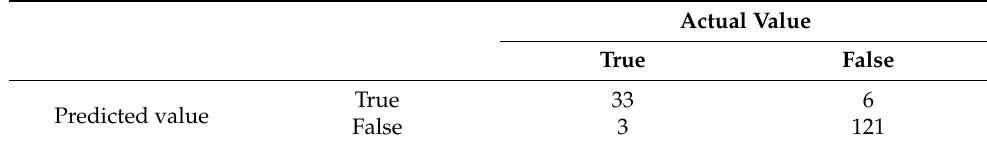
Table 2. Confusion matrix of ensemble method for identifying measurements with outlying behav- ior.